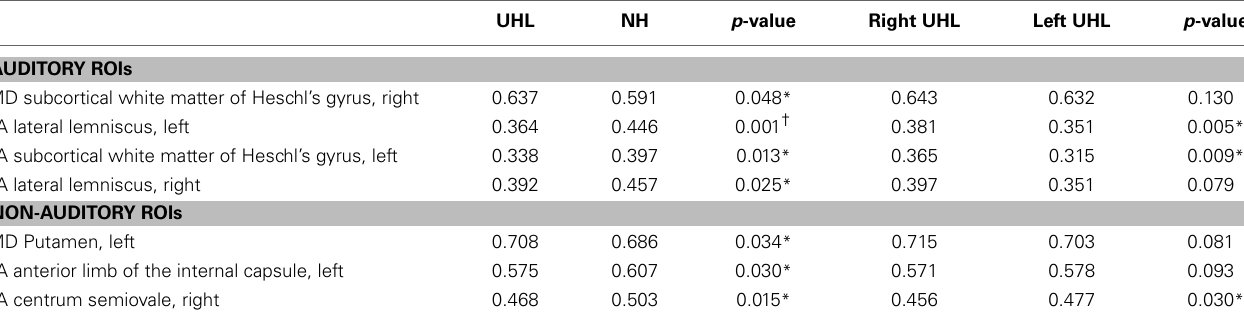
Table 4 | DTI parameters in those with unilateral hearing loss (UHL; n = 29) and normal hearing (NH; n = 20) participants amongst six auditory regions of interest (ROI) and nine non-auditory ROIs.